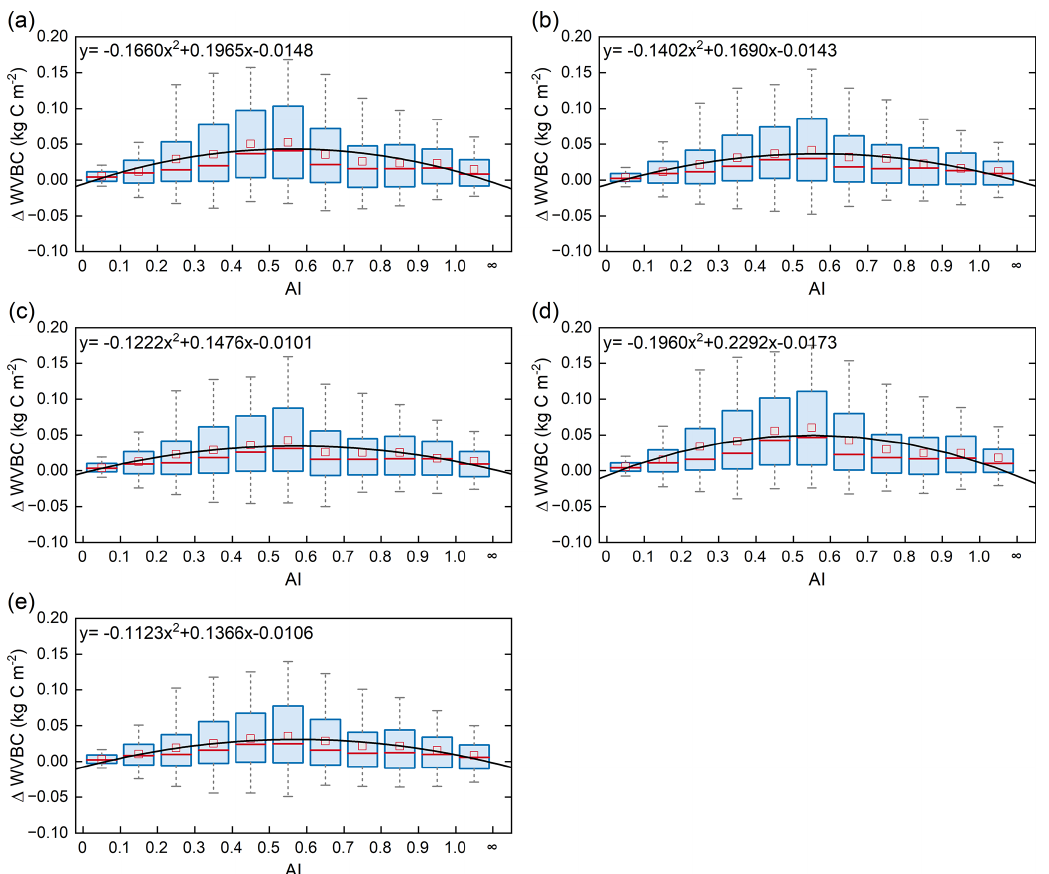
Figure 10. Relationships of the incremental change in AI and WVBC. Magnitude of change in WVBC in the historical scenario S1 (a) , CO 2 in scenario S2 (b) , CO 2 + precipitation in scenario S3 (c) , CO 2 + temperature in scenario S4 (d) , and CO 2 + radiation in scenario S5 (e) . The range of the box is 25%–75% of values, the range of the whiskers is 10%–90% of values, the small red square is average value, the red line is the median line, and the black line is the fitted curve. Positive value of the y axis represents the magnitude of increased WVBC from 1916 to 2015 under water-limited conditions, and vice versa. AI of grid cells is calculated by multiyear average precipitation and multiyear average potential evapotranspiration in the period of 1916–2015. Categories of hydrological zones include hyper-arid (AI ≤ 0.05), arid (0.05 < AI ≤ 0.2), semi-arid (0.2 < AI ≤ 0.5), sub-humid (0.5 < AI ≤ 0.65), and humid (AI >